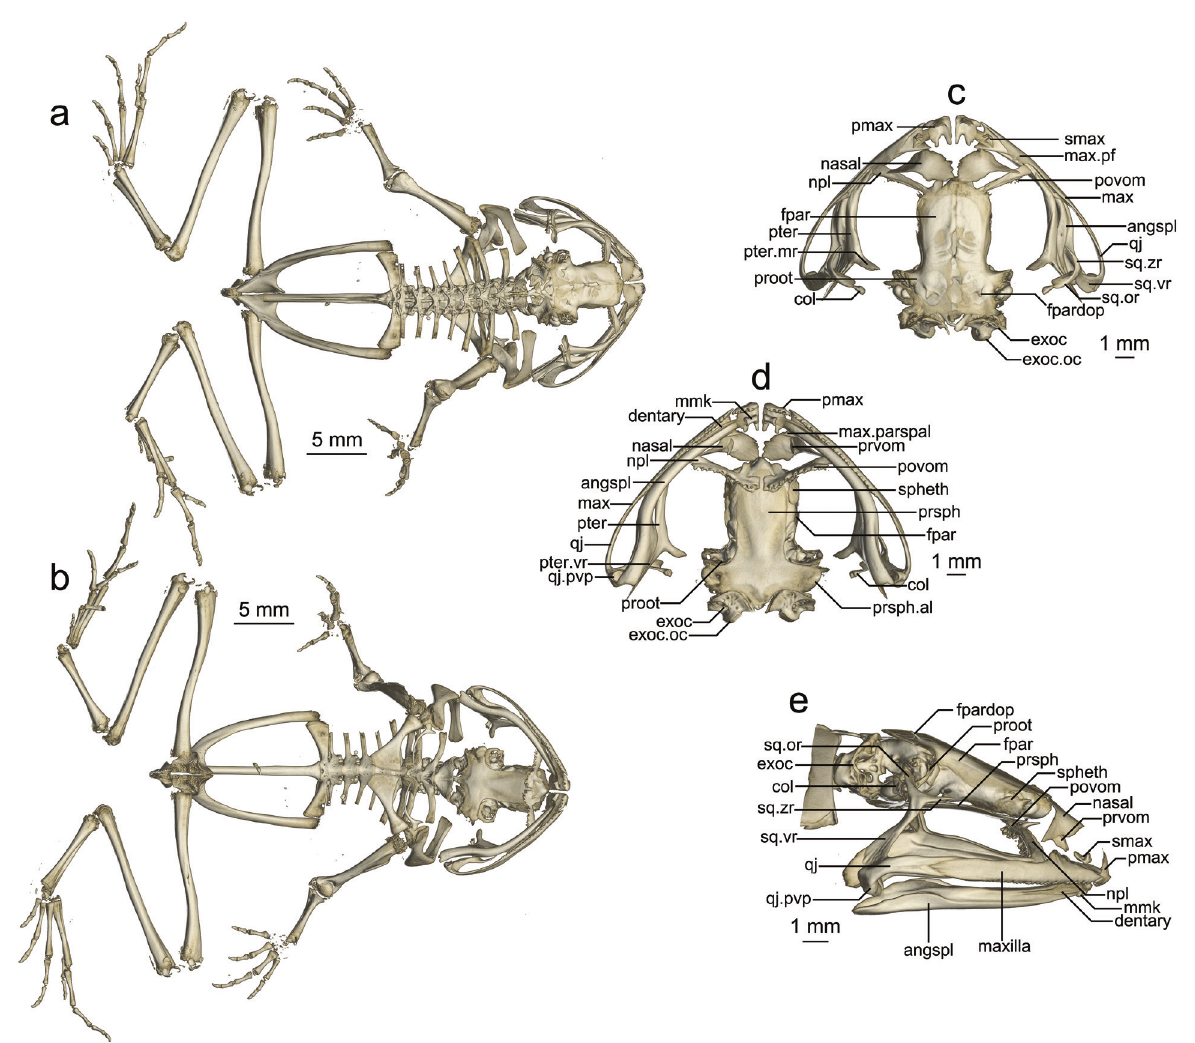
Figure 9. The skeleton of Plethodontohyla alluaudi (MNHN 1901.235) rendered via micro-CT scanning. ( a–b ) Full skeleton in ( a ) dorsal and ( b ) ventral view. ( c–e ) Skull in ( c ) dorsal, ( d ) ventral and ( e ) lateral view. Abbreviations are as in Fig. 7. For a 3D rotational model, see Suppl. material